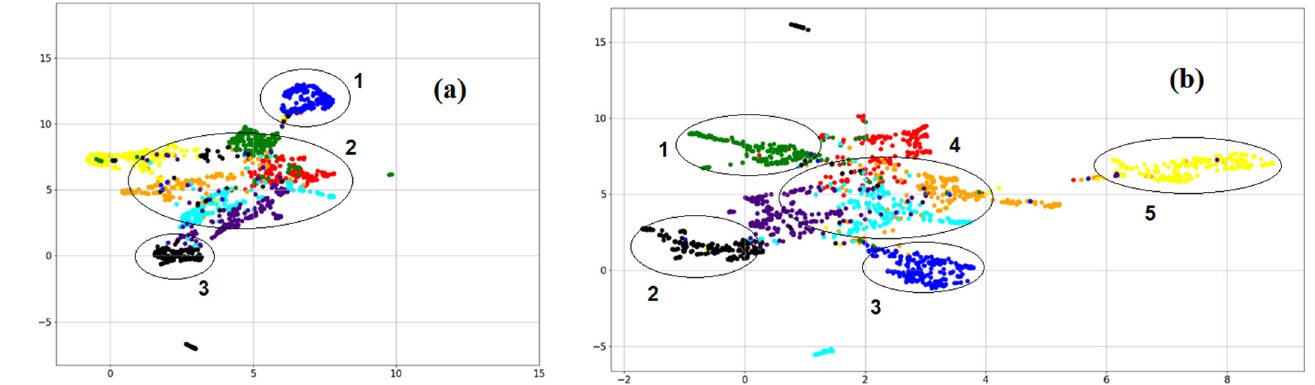
Figure 4. Graphical representation of the cosine metric values for the marked corpus of documents with two different TF-IDF presentations using the term occurrence frequency in documents: ( a ) the double normalized frequency of an object in the document (3) and the inverse document frequency (4) (here 1, 2, 3 are the numbers of clusters); ( b ) the occurrence frequency of an object in the document (2) and the probabilistic inverse document frequency (6) (here 1, 2, 3, 4, 5 are the numbers of clusters)